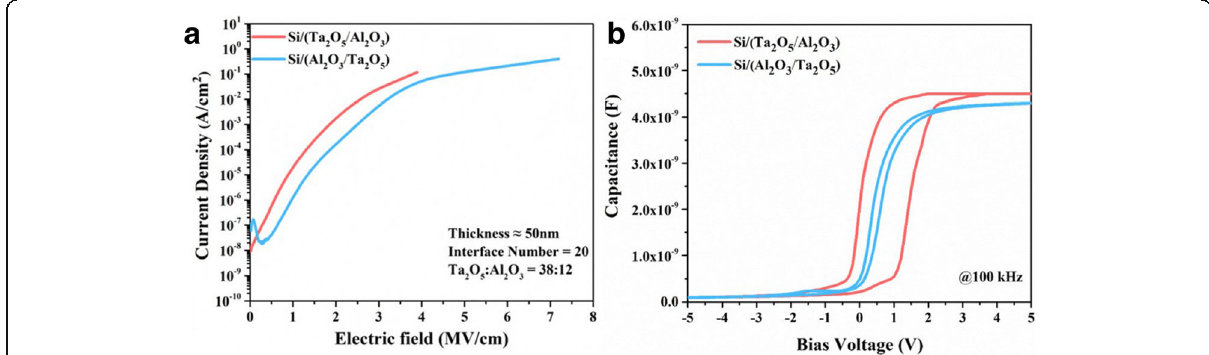
Fig. 6 a The I-V and b the C-V behaviors of films with the different deposition